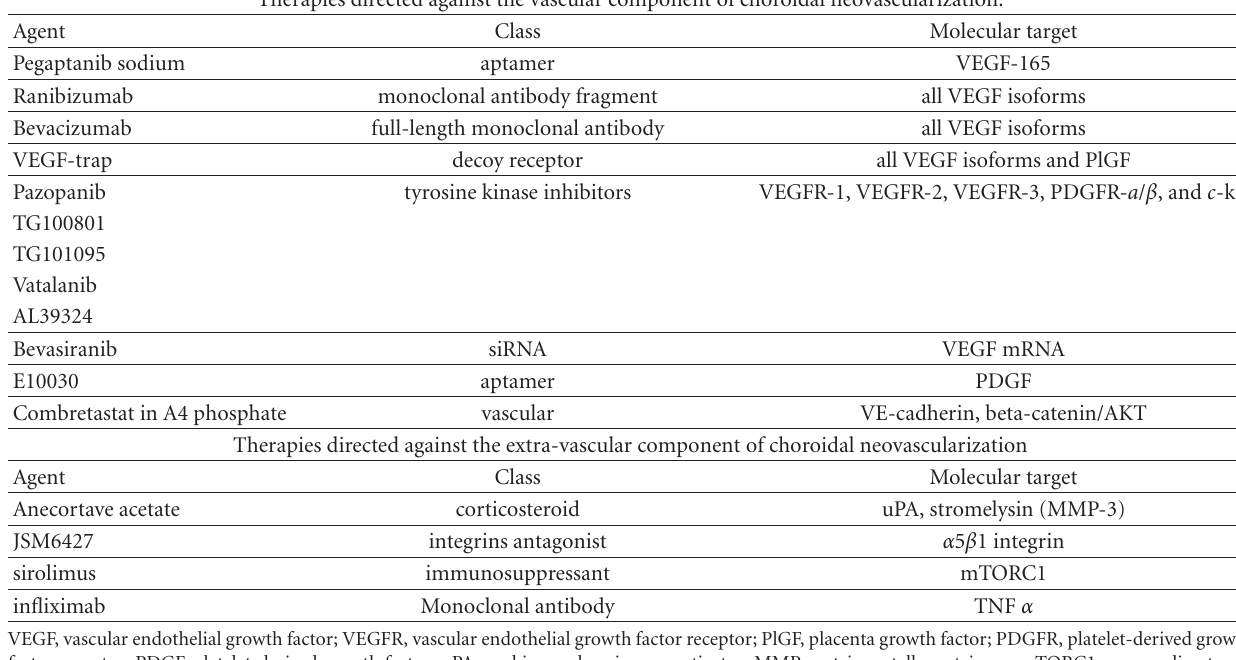
Table 1: Therapeutic approaches for choroidal neovascularization. Therapies directed against the vascular component of choroidal